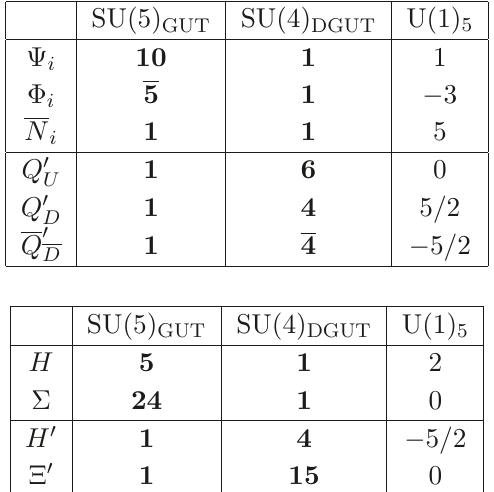
SU(4) DGUT unified ×